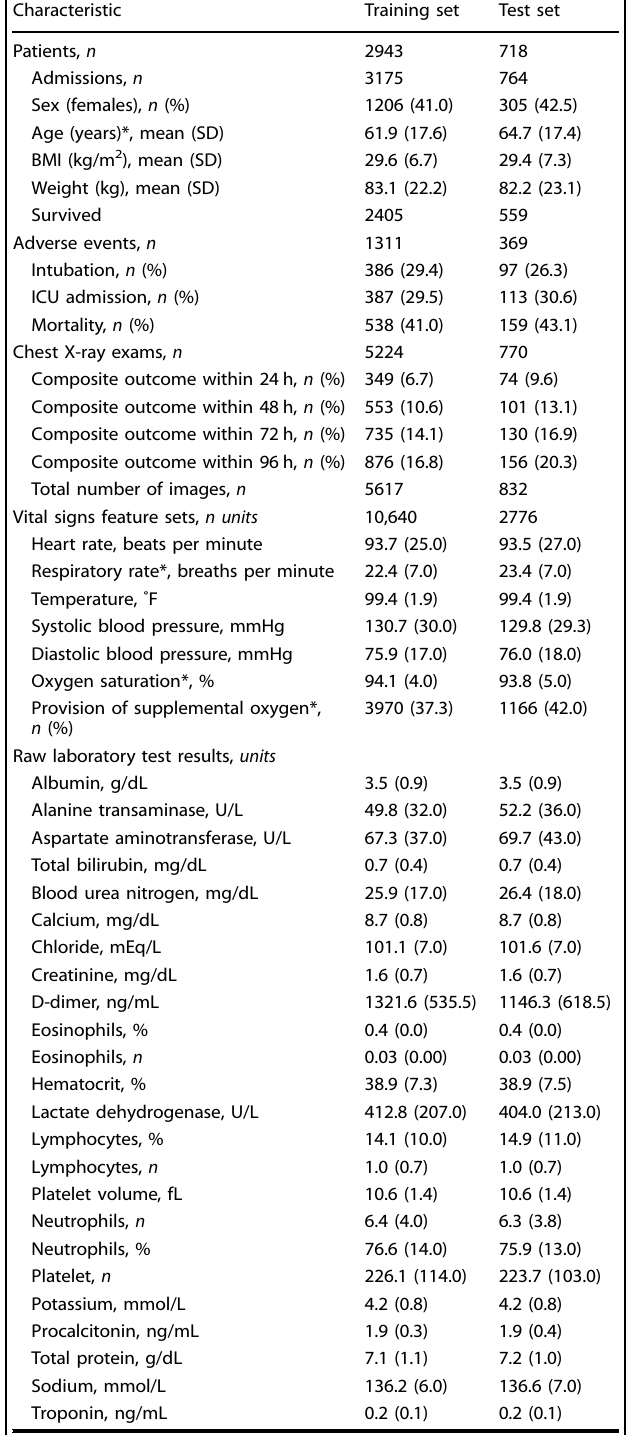
Table 1. Description of the characteristics of the patient cohort included in the training and test sets and the mean and interquartile range statistics of the raw vital signs and laboratory test results used for COVID-GBM.